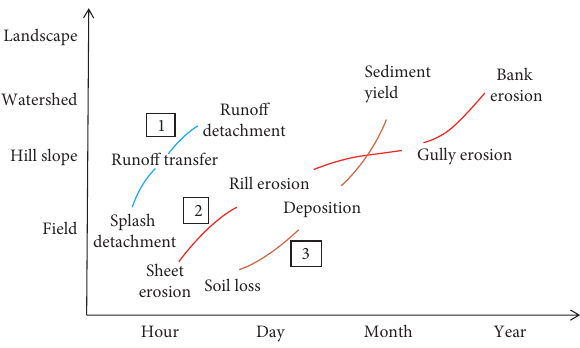
Figure 1: Spatiotemporal continuum: erosion processes (1), forms (2), and features (3) (source: